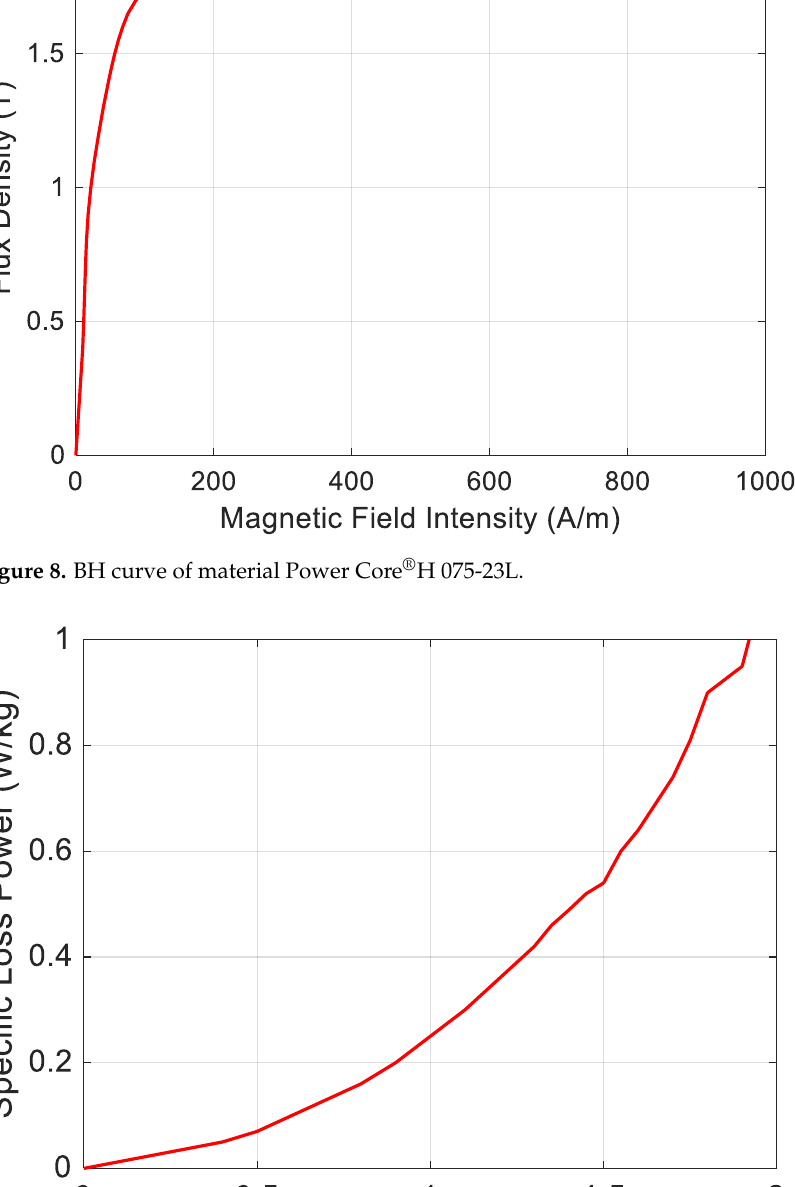
Figure 7. Testing geometry of three-phase compensation choke (quarter symmetry used).